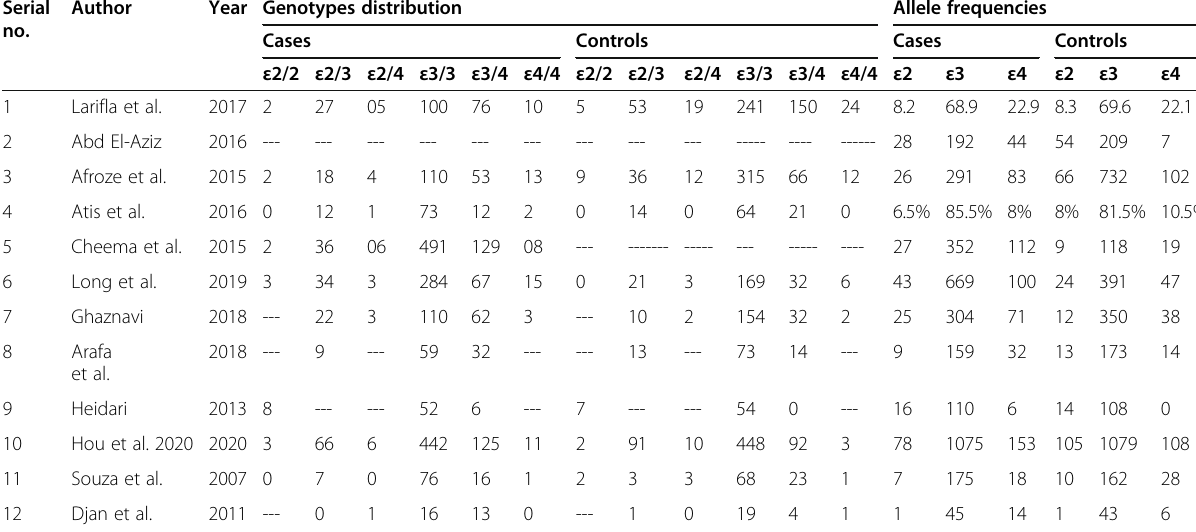
Table 2 In each included study the distribution of genotypes and frequencies of APOE allele Serial